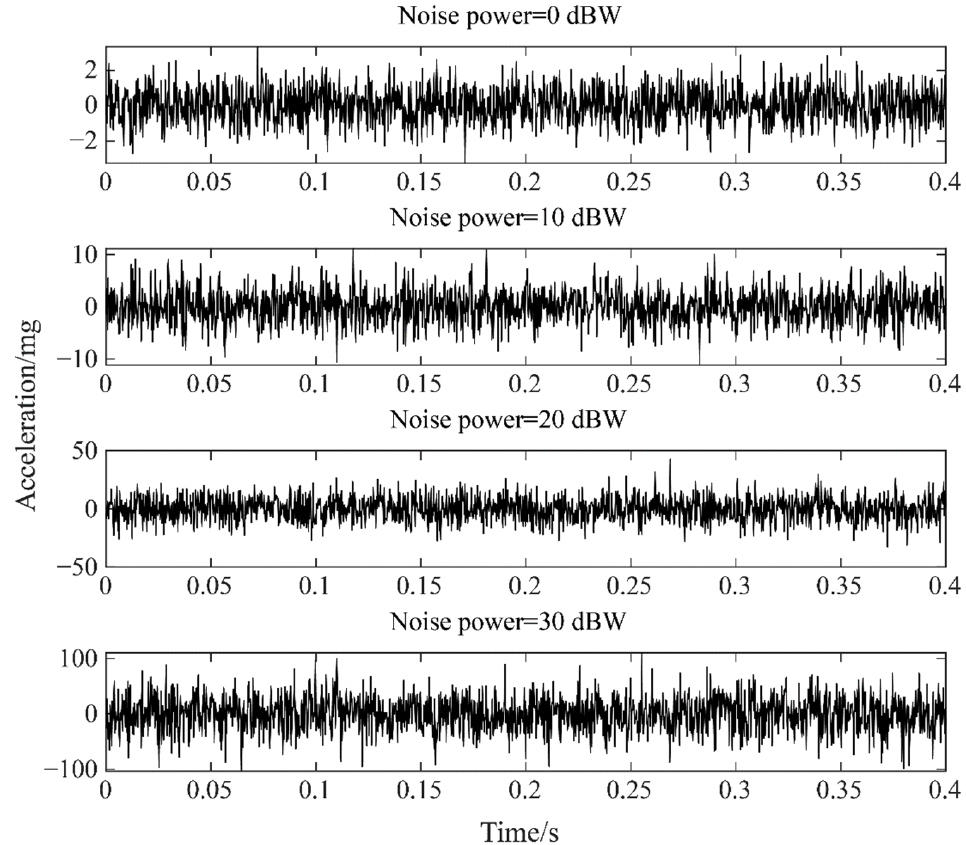
Figure 11. Synthetic WGN of different power.